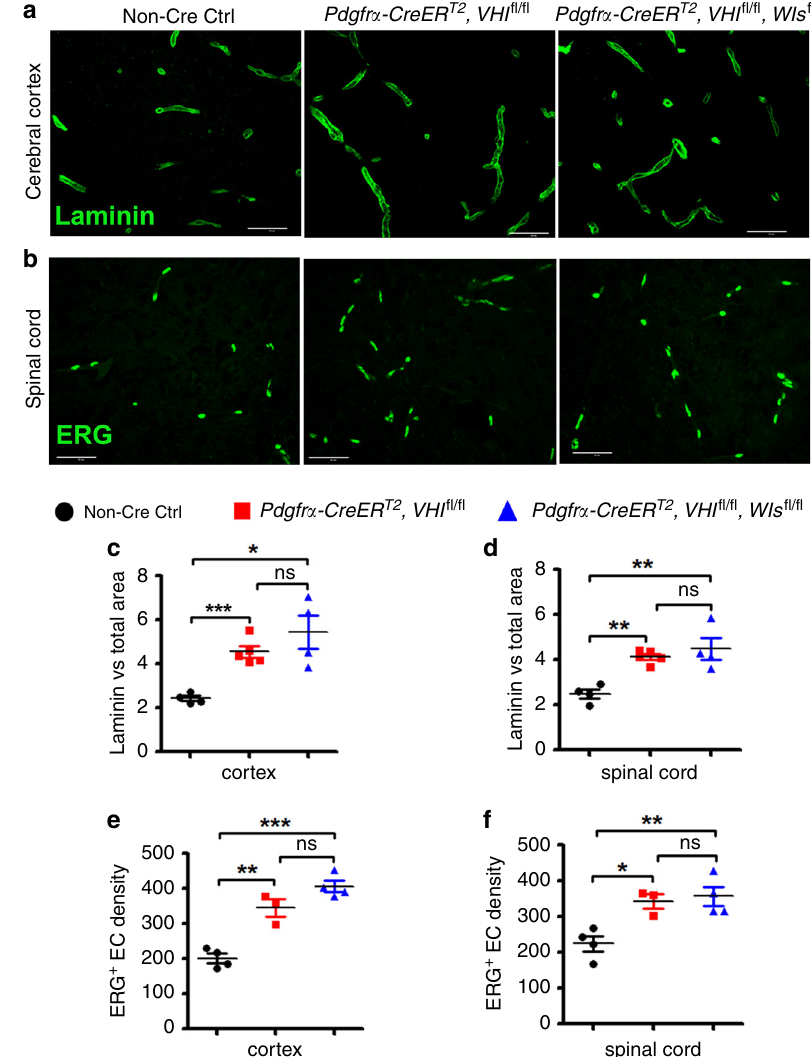
Fig. 5 Blocking Wnt secretion from oligodendrocyte progenitor cells (OPCs) does not affect HIF α -regulated CNS angiogenesis. a , b Representative confocal images of Laminin-labeled blood vessels and ERG-labeled ECs in each group of mice. Scale bars = 50 µ m. c , d Percent of Laminin-occupying area among total assessed area. Welch ’ s ANOVA followed by unpaired t test with Welch ’ s correction, * P < 0.05, *** P < 0.001, ns, not signi fi cant. W (2,5.256) = 30.38, P = 0.0013 for cortex. One-way ANOVA followed by Tukey ’ s multiple comparisons, ** P < 0.01, ns, not signi fi cant. F (2,10) = 12.67, P = 0.0018 for spinal cord. n = 4 Ctrl, 5 VHL cKO, 4 VHL/WLS cKO. e , f Densities (#/mm 2 ) of ERG + ECs. One-way ANOVA followed by Tukey ’ s multiple comparisons, * P < 0.05, ** P < 0.01, *** P < 0.001, ns, not signi fi cant. F (2,8) = 39.80, P < 0.0001 cortex, F (2,8) = 10.30, P = 0.0064 spinal cord. Mice from the above three groups were injected with tamoxifen at P1, P2, and P3 and sacri fi ced at P8. n = 4 Ctrl, 3 VHL cKO, 4 VHL/WLS cKO. Data are shown as mean ± s.d. Source data of c – f are provided as a Source Data fi